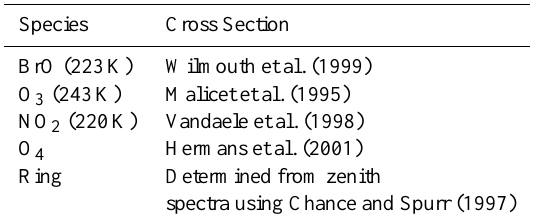
Table 1. Absorber cross sections used in the MAX-DOAS fitting. Species Cross Section